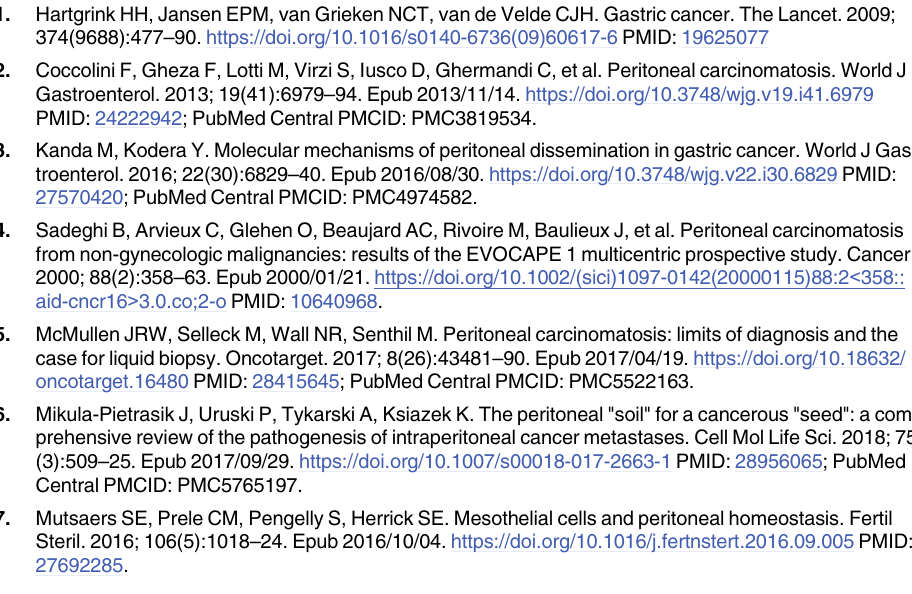
S2 Fig. Survival based on Tks5 expression on gastric cancer cells. No significant difference was found between the Tks5-positive and -negative groups in all patients (A; n = 110) and patients with R0 curative operation (B; n = 98). S1 Table. Tks5 expression of peritoneal mesothelial cells among 110 gastric cancer cases and 17 healthy cases. Abbreviation: PMC, Peritoneal mesothelial cells. S2 Table. Postoperative recurrence of 98 gastric cancer patients based on Tks5 expression on gastric cancer cells. � Fisher’s exact test. Abbreviation: IQR, Interquartile